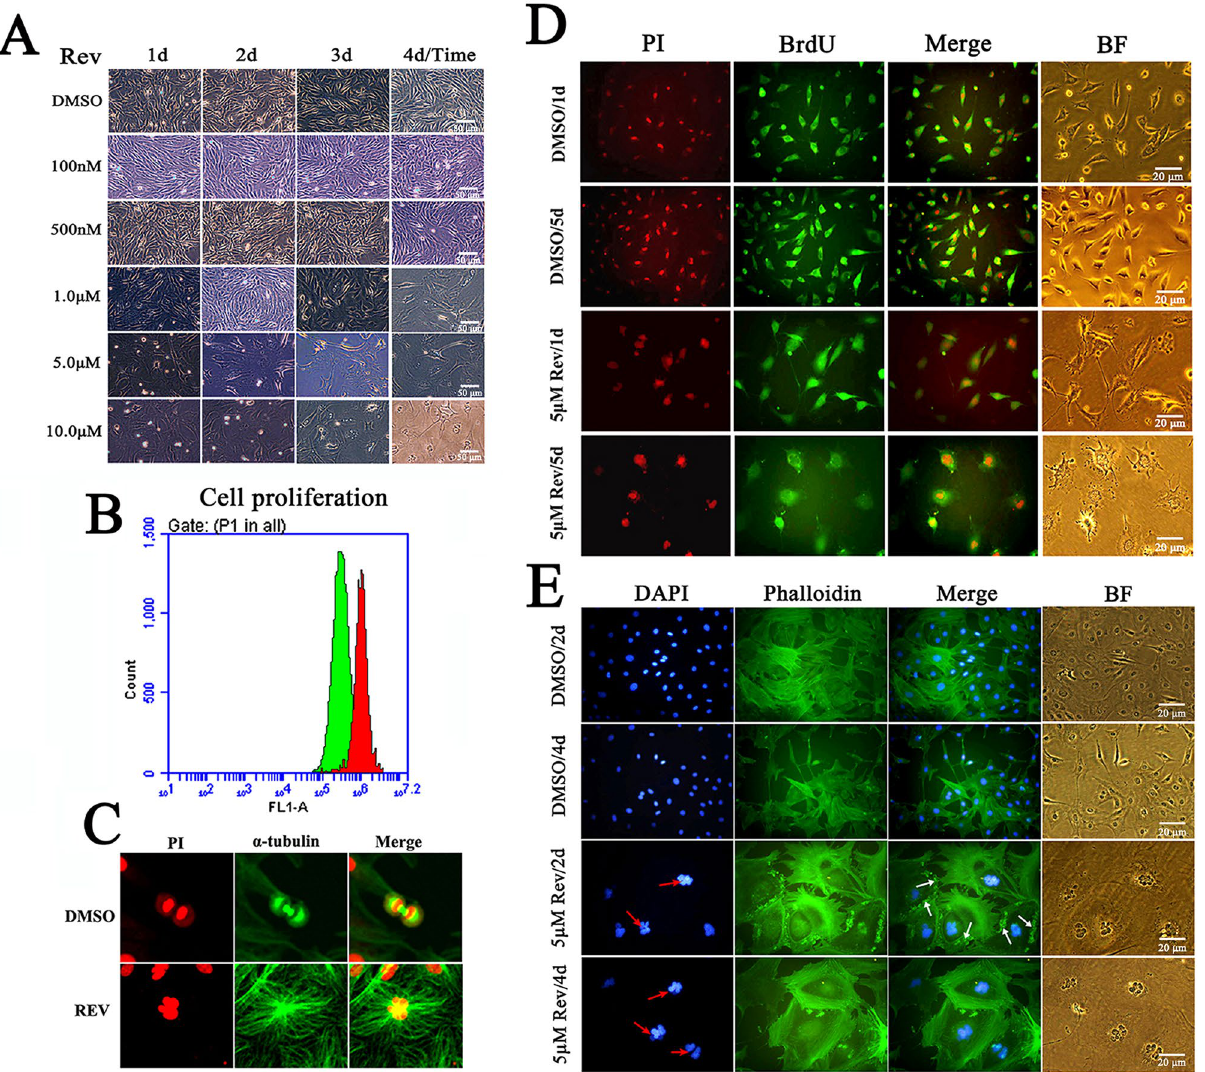
Figure 1. Effects of reversine on the biological characterization of sheep fibroblasts. ( A ) Effects of different concentrations of reversine on the morphology of fibroblasts for 4 days. ( B ) Cell proliferation was detected using flow cytometry. ( C ) Expression of α-tubulin (Green) was analyzed by immunofluorescence and counterstained with PI (red); ( D ) Immunodetection of BrdU incorporation for cell proliferation analysis. ( E ) Cells were stained with phalloidin (green), and counterstained with DAPI (blue). Multinucleated giant cells strongly expanded actin network and stress